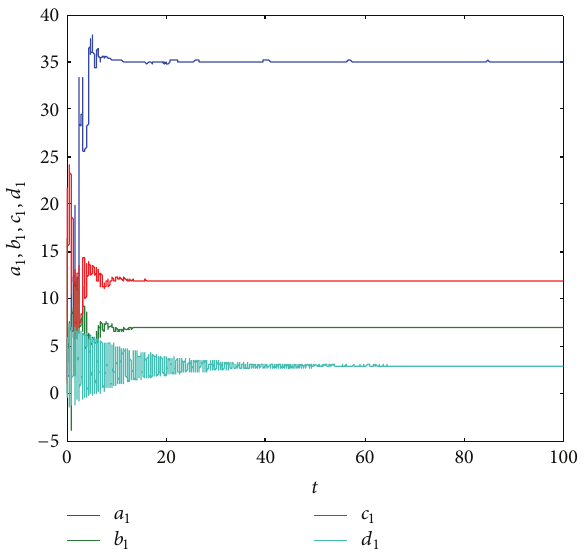
Figure 5: Time evolution of parameter estimations for system (34).